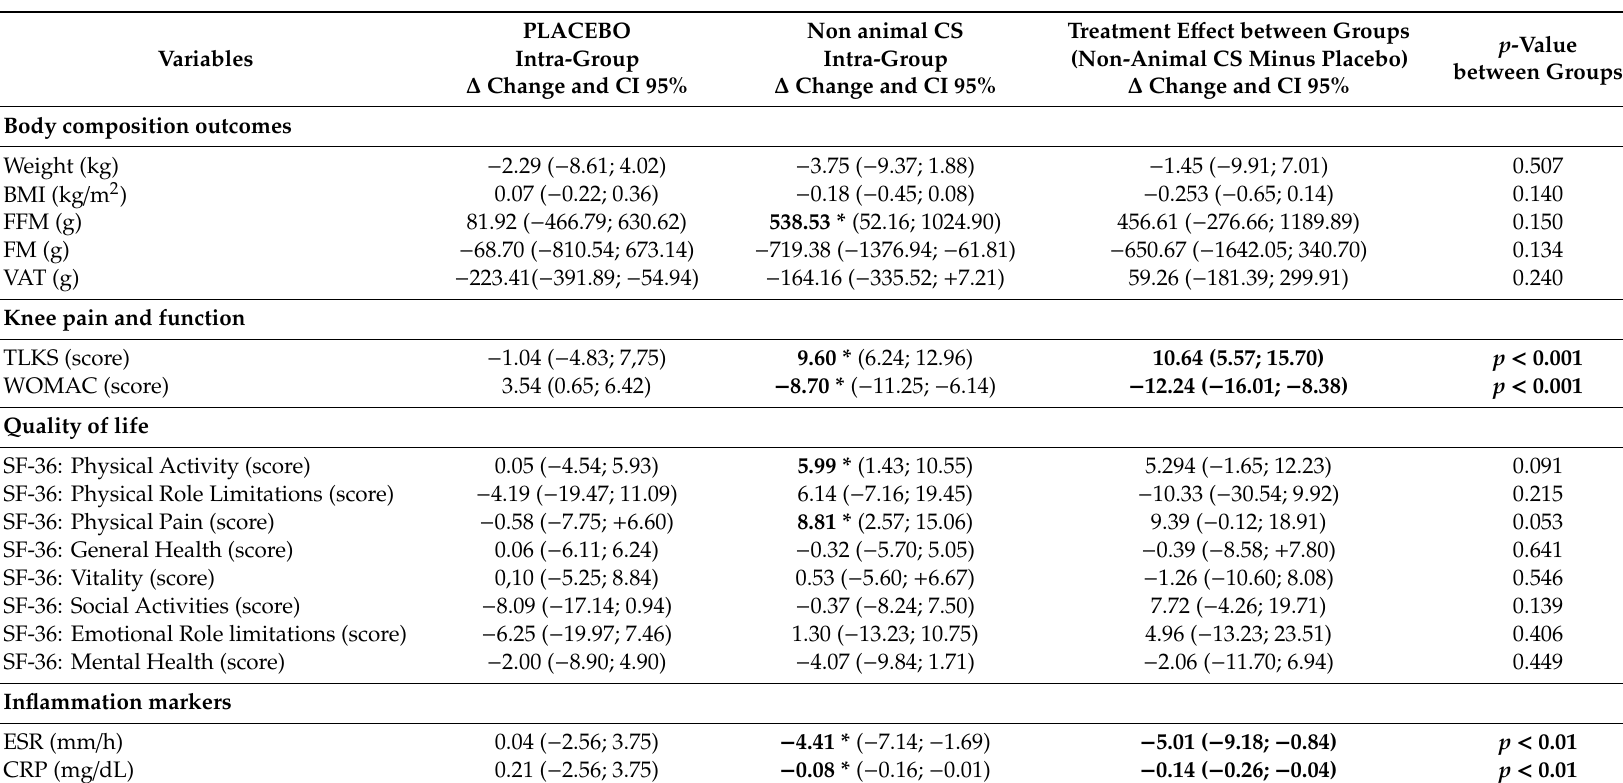
Table 3. Within-group mean changes from baseline (from day 0 to the end of the supplementation) for clinical markers. * in bold: value with p <